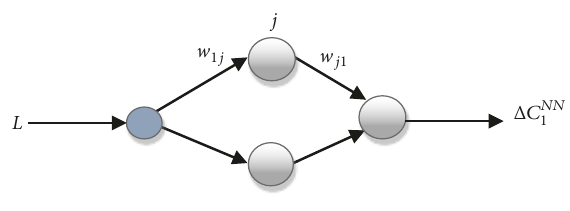
Figure 4: Neural-network